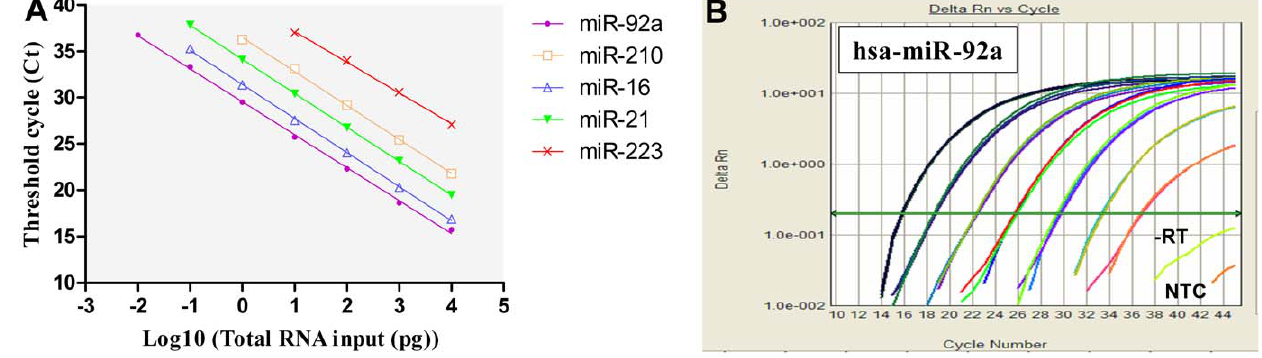
Figure 2. Dynamic range and sensitivity of the S-Poly(T) method used in miRNA quantification. A: Correlation of total RNA input to the threshold cycle (Ct) value. Five miRNAs including hsa-miR-92a, hsa-miR-210, hsa-miR-16, hsa-miR-21 and hsa-miR-223 were assayed by the S-Poly(T) method with a series of 10-fold diluted total RNAs prepared from HEK293 cells. The amount of total RNA in each qPCR reaction was ranged from 10 ng to 0.01 pg. The amplification efficiency was 96% (miR-92a), 95% (miR-210), 91% (miR-16), 90% (miR-90), and 101% (miR-223), respectively, and the correlation coefficients (R 2 ) for each miRNAs was . 0.99. B: Amplification plot of hsa-miR-92a over seven orders of magnitude. NTC: no-template control; -RT: no-reverse transcriptase control. All PCR reactions were performed in